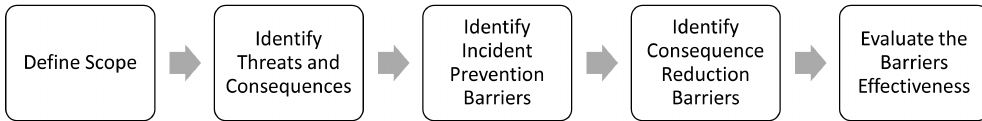
Figure 2. The Bow-Tie method (adapted from [20]).